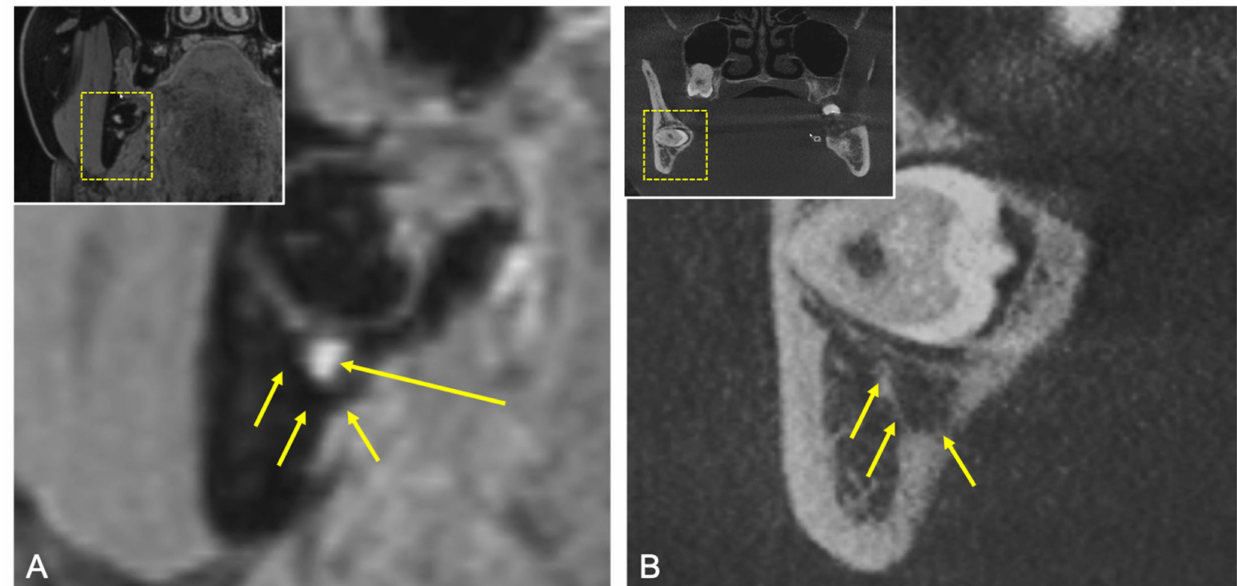
Figure 4. ( A ) Coronal reconstruction of the 3D-DESS MRI. For orientation, the dotted rectangles in the corner show the enlarged area. Short arrows showing the osseous boundaries of the IAC and the long arrow showing the MRI signal hyperintensities by the IAN’s tissue. ( B ) Coronal reconstruction of the CBCT. For orientation, the dotted rectangles in the corner show the enlarged area. Short arrows showing the osseous boundaries of the